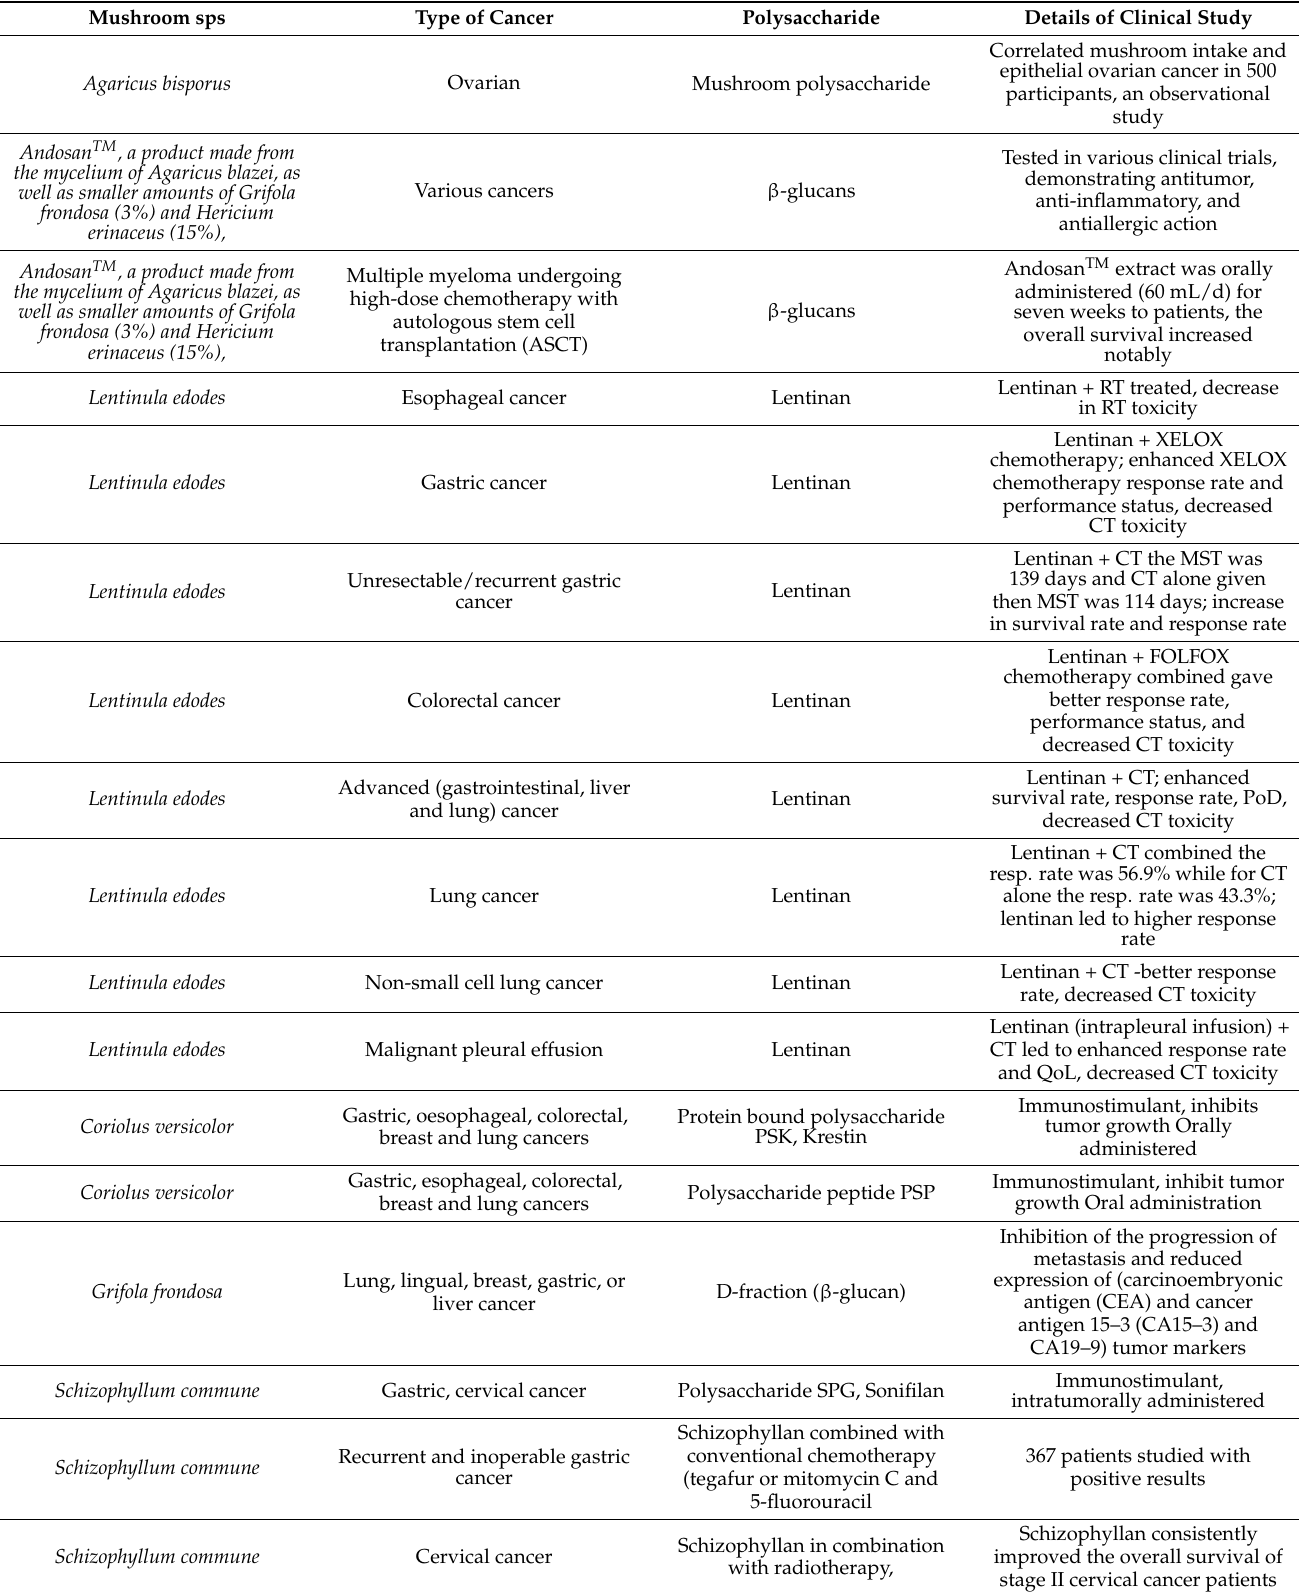
Table 2. Clinical studies based on mushroom polysaccharides-based